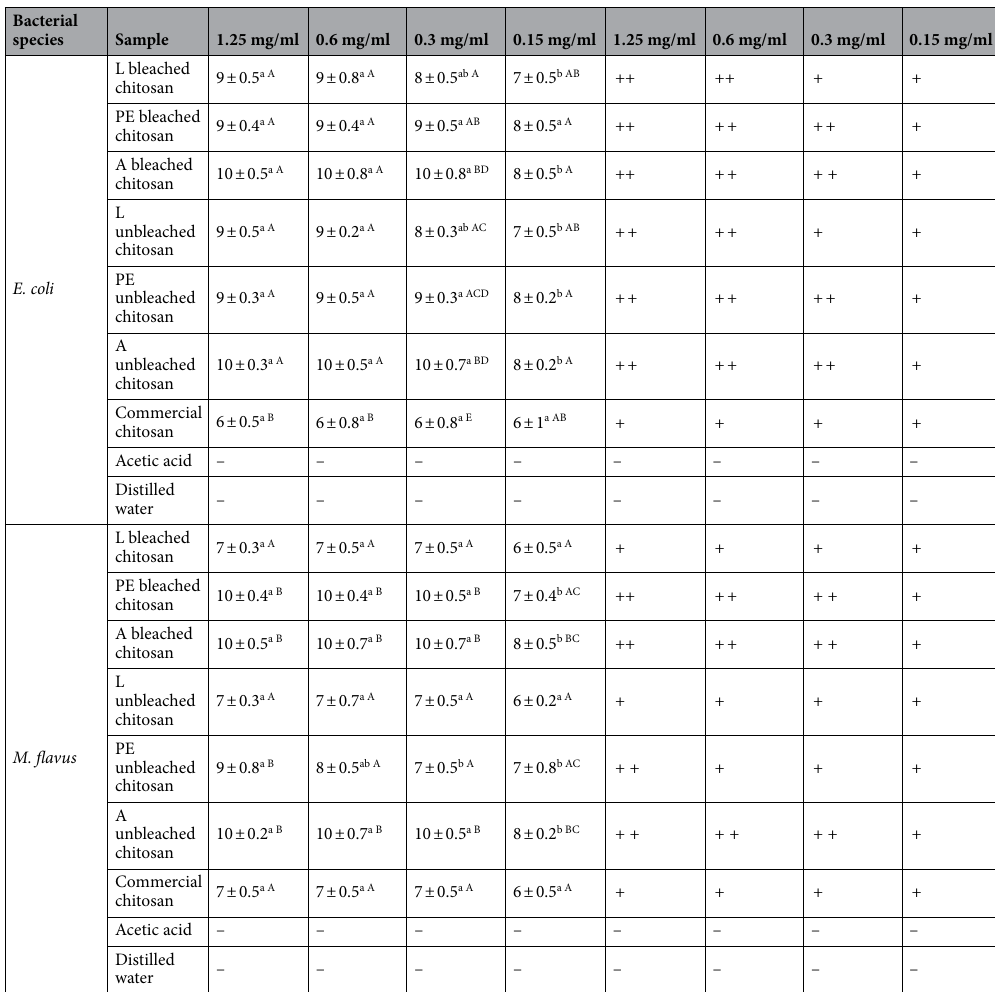
Literature data showed the antimicrobial potential of chitosan, but there was still little information obtained from the investigation of insect-derived chitosan. Moreover, it is still unknown whether the biopolymer acted better on Gram-positive or Gram-negative bacteria. In this work, for the first time, the antimicrobial potential of chitosan produced from different biomasses of H. illucens (larvae, pupal exuviae and dead adults) is investigated. Pictures of the inhibition zones of all bleached and unbleached chitosan samples, acetic acid and distilled water were reported in Fig. 3. Our data can be compared with those reported by Lagat et al . 68 and Kemboi et al . 69 . Lagat et al . 68 tested chitosan from pupal exuviae of H. illucens against two Gram-negative bacteria ( E. coli and Pseudomonas aeruginosa ) and two Gram-positive bacteria ( S. aureus and Bacillus subtilis ), at the concentrations of 5, 2.5, 1 and 0.5 g/ml. Kemboi et al . 69 tested chitosan from pupal exuviae of Hermetia illucens on Ralstonia Sola- nacearum, using disc diffusion test at the similar concentration range. Both obtained larger inhibition diameters than ours, but at much higher concentrations. Indeed, our results, considering the different order of magnitude of the concentrations tested, revealed a good antimicrobial capacity and were very encouraging. Basseri et al. 70 tested chitosan obtained from different developmental stages (adults and nymphs) of two cockroaches, Periplaneta americana and Blattella germanica . They tested solutions of chitosan at the concen- tration of 10 mg/ml on three different bacteria: E. coli and P. aeruginosa , as Gram-negative, and S. aureus, as